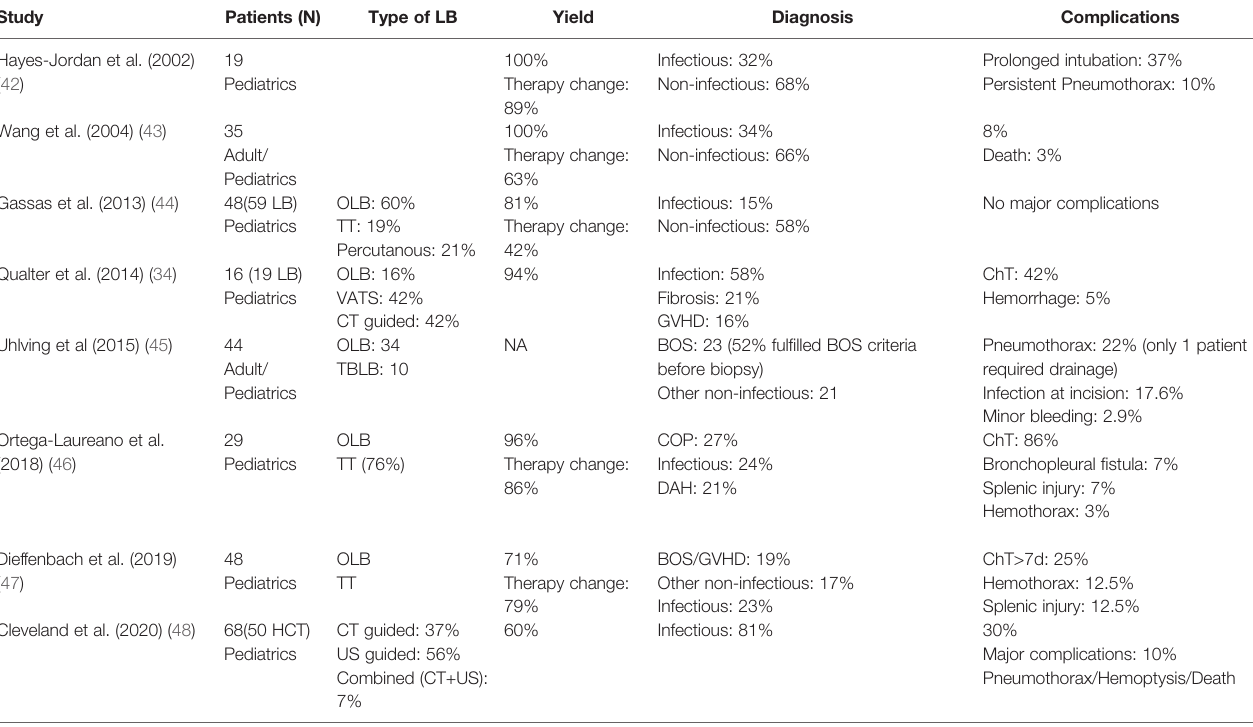
TABLE 3 | Summary of studies evaluating lung biopsy in children post-HCT with pulmonary complications.